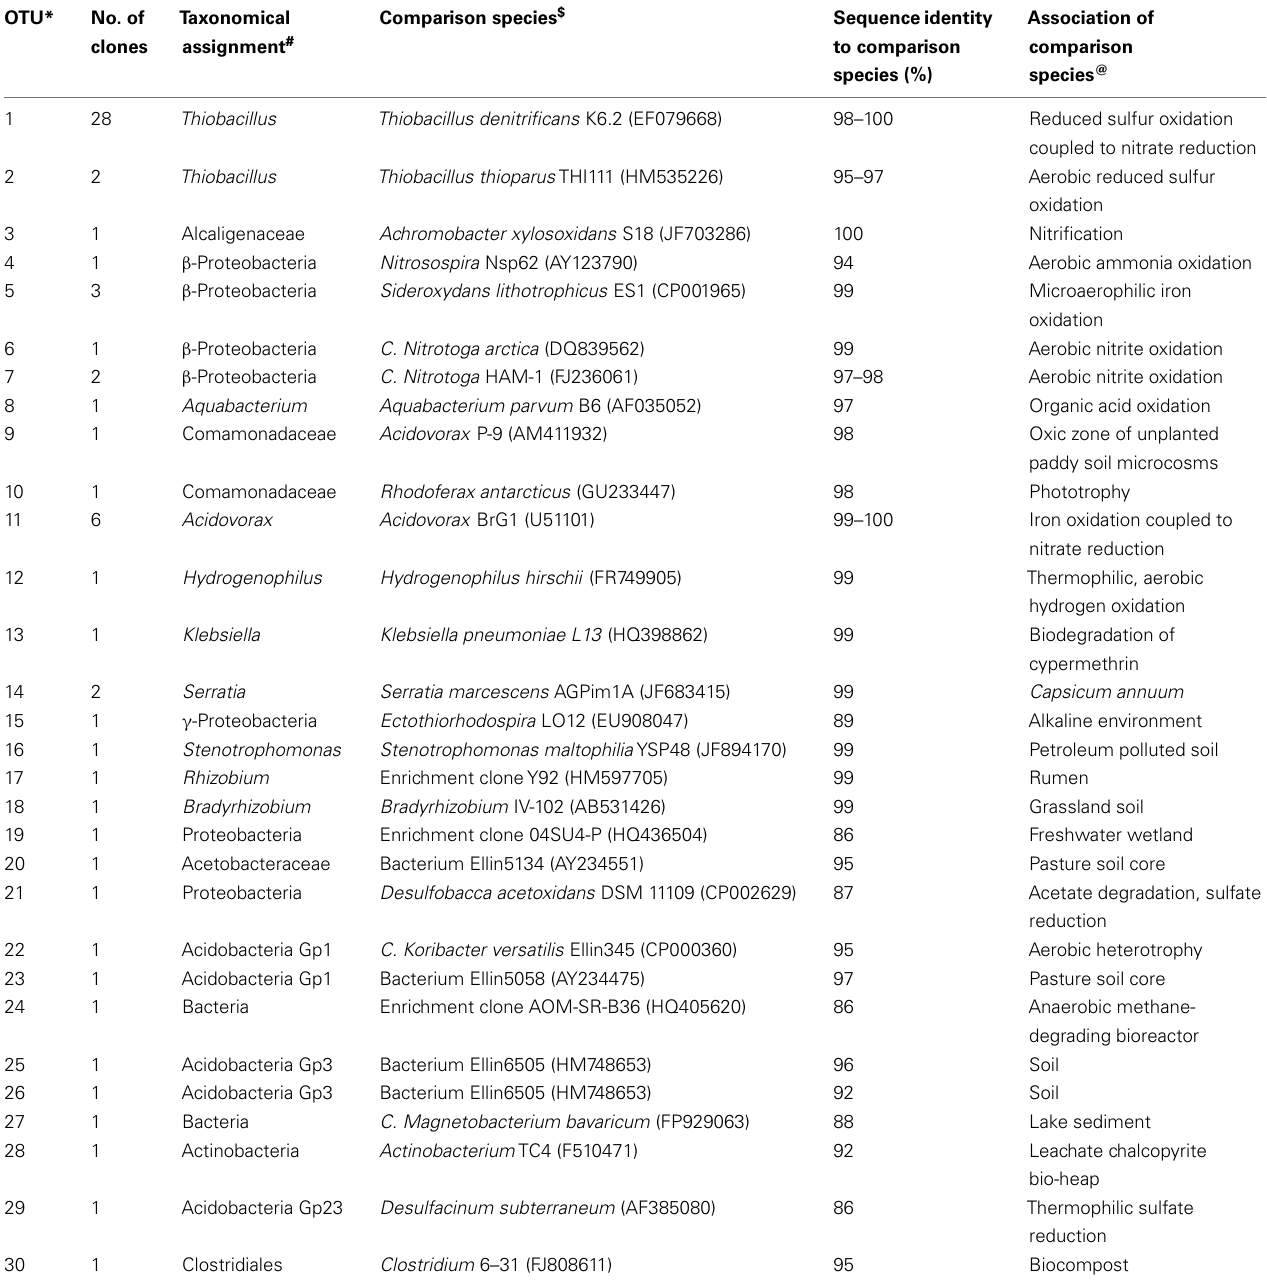
Table 1 | Overview clone library data from the groundwater of Het